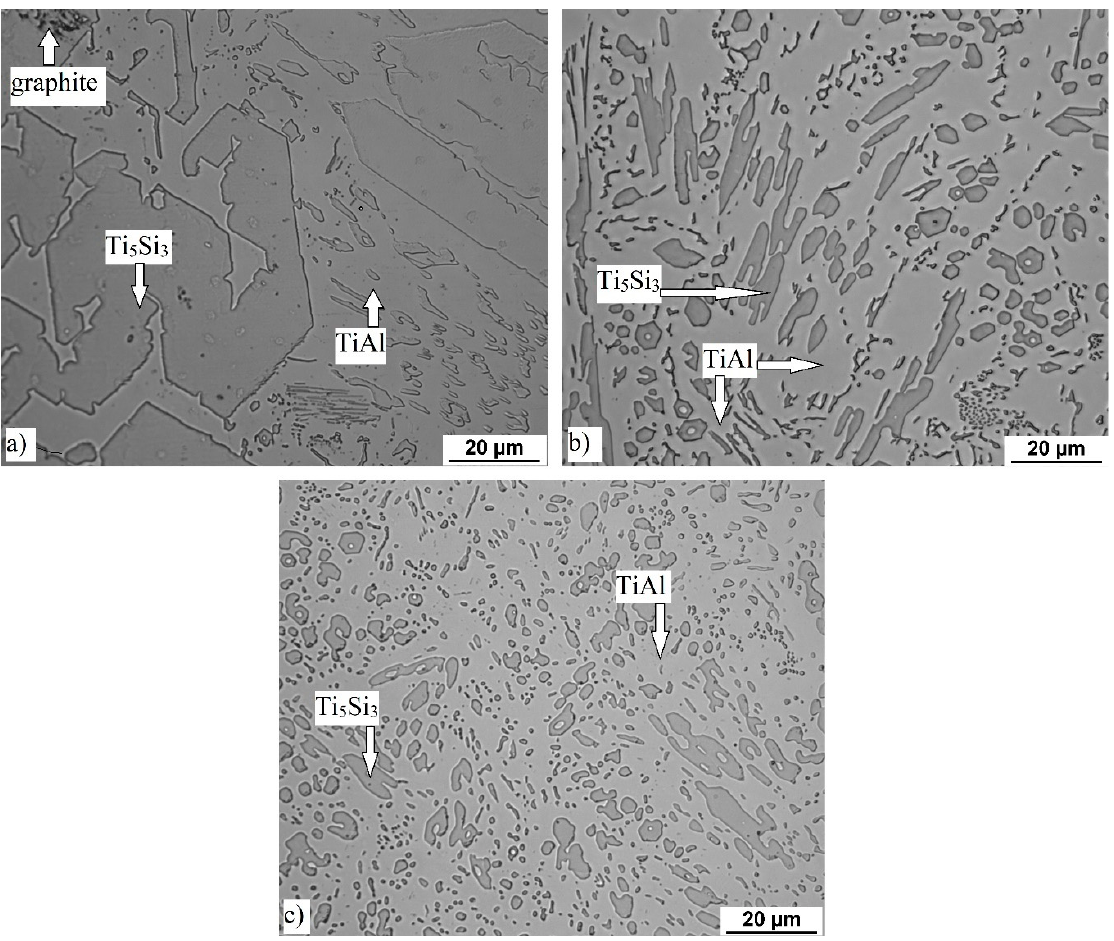
Figure 2. Optical micrographs of the tested alloys: ( a ) TiAl15Si15 in as-cast state, ( b ) TiAl35Si5in as-cast state, ( c ) TiAl35Si5 after hot isostatic pressing (HIP).